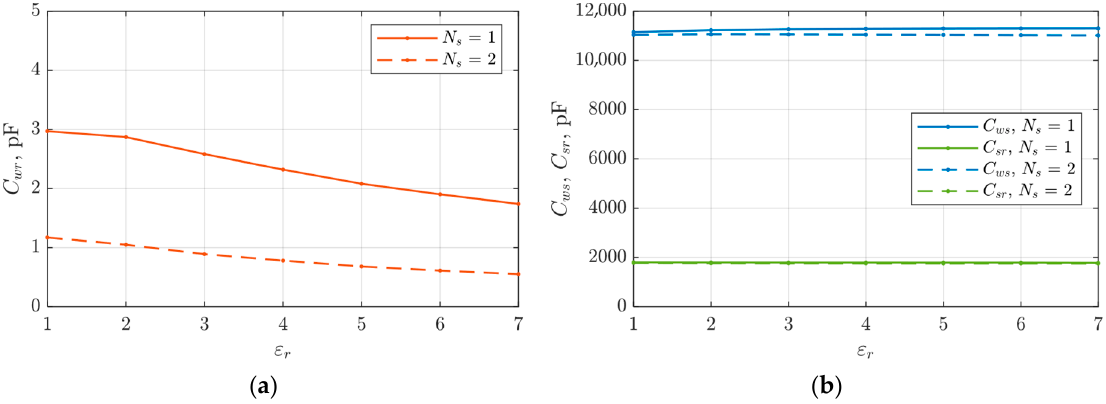
Figure 14. Characteristics of capacitance changes: ( a ) C wr , ( b ) C ws and C sr depending on the value of the electric permeability of the wedge closing the slot and the number of grounded shielding wires. ( B s0 = 2 mm).